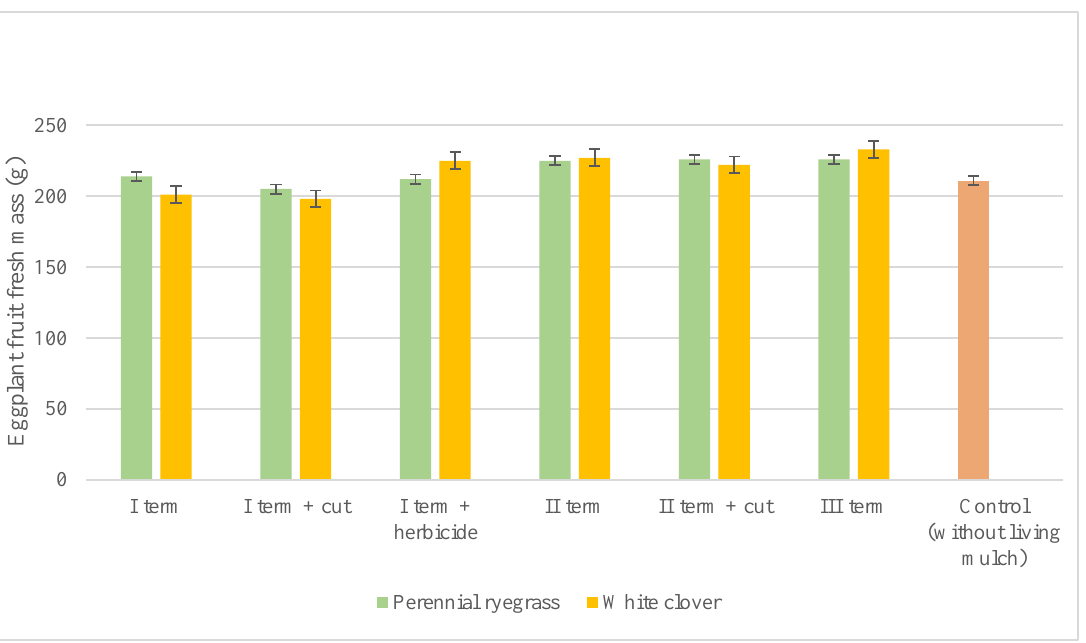
Figure 3. The effect of living mulches species, sowing term and living mulches management on eggplant marketable yield [t·ha − 1 ].